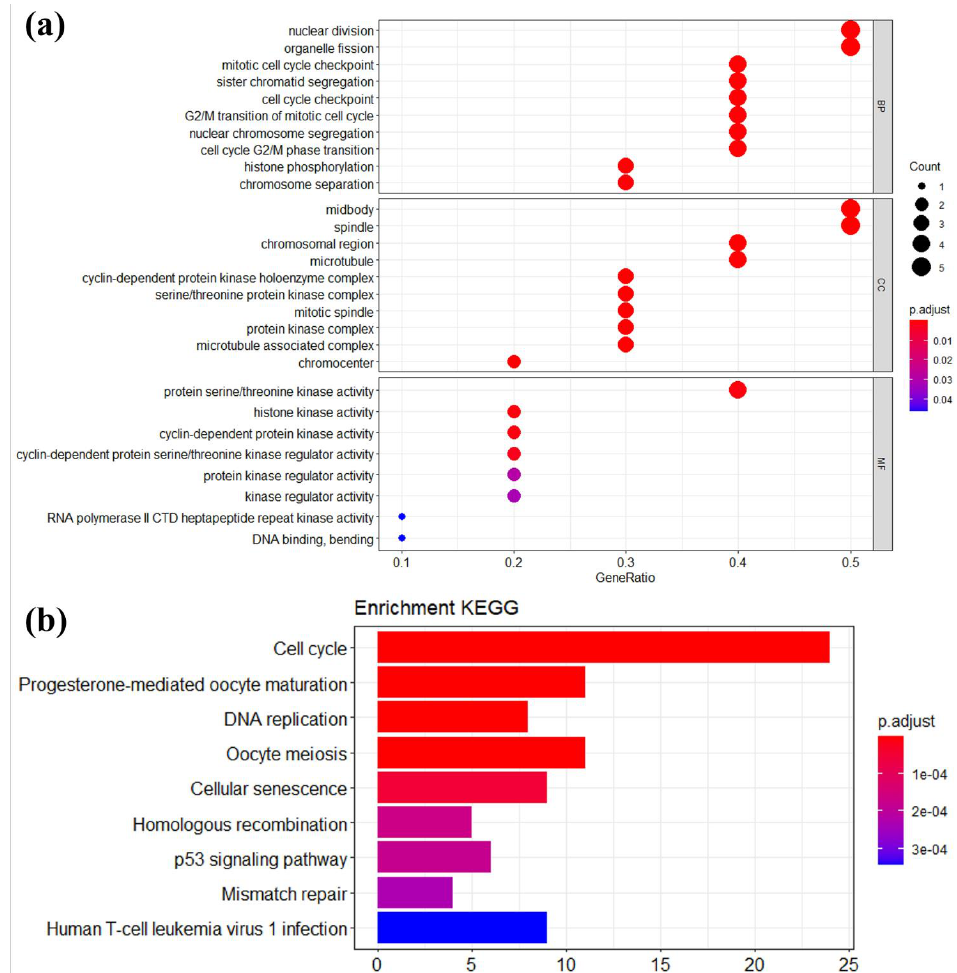
Figure 6. Functional enrichment analysis of 147 module genes. ( a ) GO analysis for hub genes. ( b ) KEGG pathway analysis for hub genes. BP, biological process; CC, cellular component; MF, molecular function.